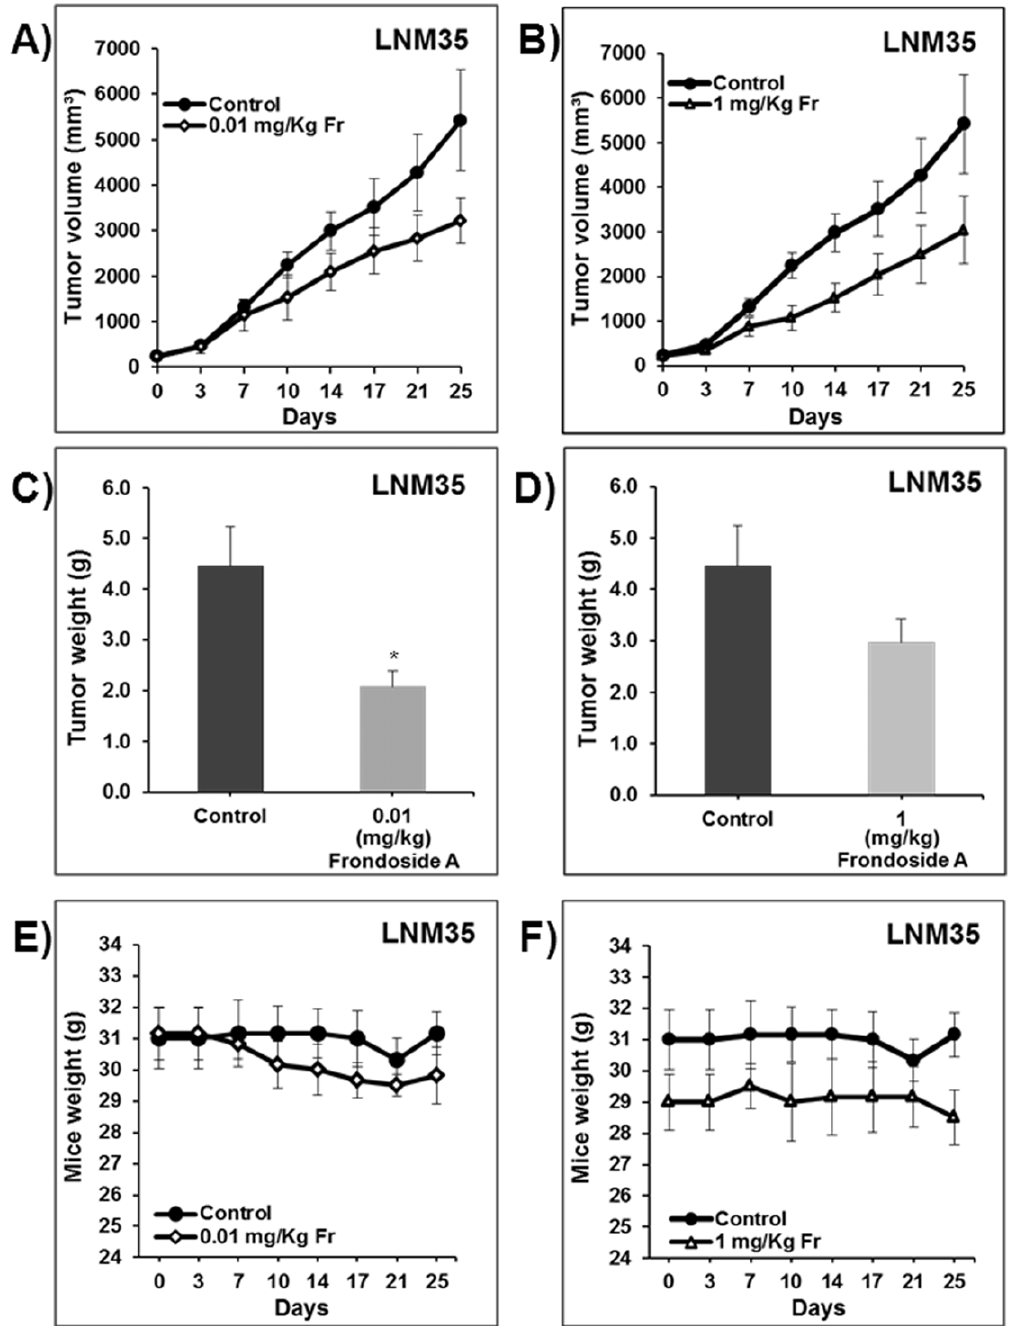
Figure 3. Frondoside A induces regression of established LNM35 xenografts. A) & B ) Tumor volume of LNM35 xenografts inoculated subcutaneously in nude mice and treated with Frondoside A (0.01 and 1 mg/kg, intra-peritoneal injections, respectively) or control carrier solution alone, for a total of 25 days. Data points represent the mean 6 S.E.M. of 6 mice per group. C) & D ) Tumor weight obtained from the same control and treated nude mice. Data points represent the mean 6 S.E.M. of 6 mice per group. Columns , mean; bars , S.E.M. E) & F ) Body weight of these mice. Data points represent the mean 6 S.E.M. of 6 mice per group. * Significantly different at P , 0.05. doi:10.1371/journal.pone.0053087.g003 after inoculation, when tumors had reached the volume of approximately 150 mm 3 , animals (six in each group) were treated in the first protocol for 25 days with Frondoside A (0.01 and